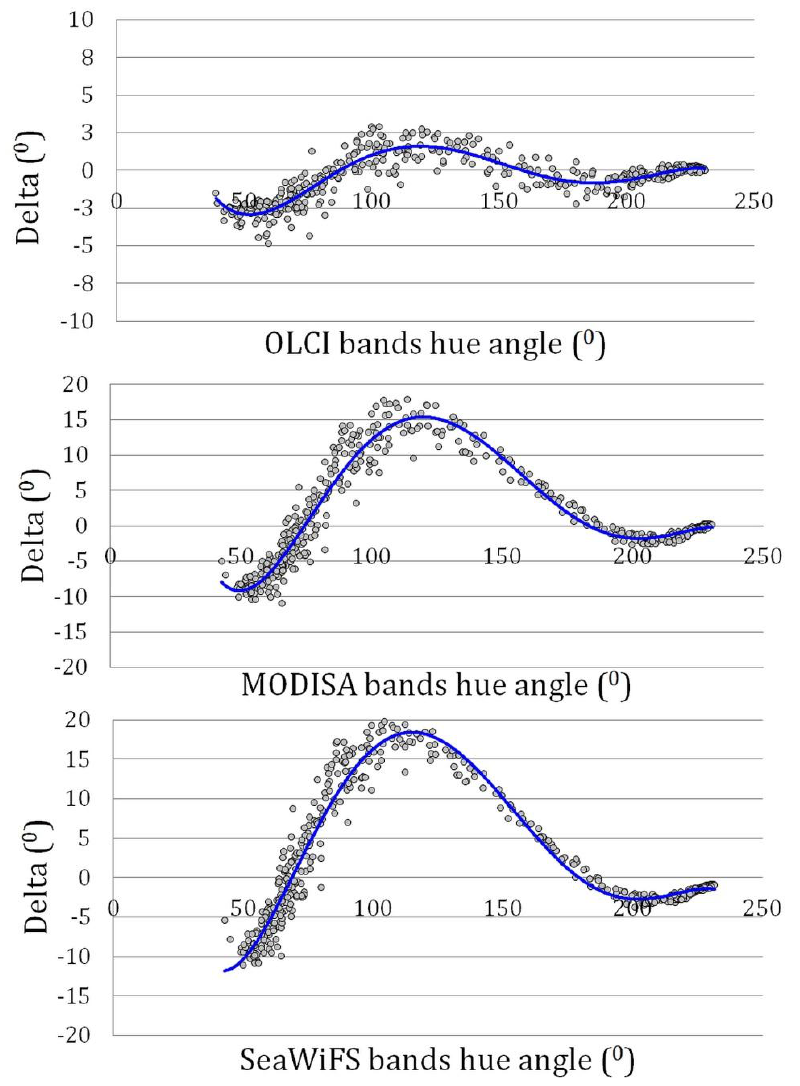
Figure 6. Deviation delta (°) from the hyperspectral hue angle as function of OLCI, MODIS and SeaWiFS hue angles derived from linear satellite band combinations. Note the change in the vertical scale from upper to lower